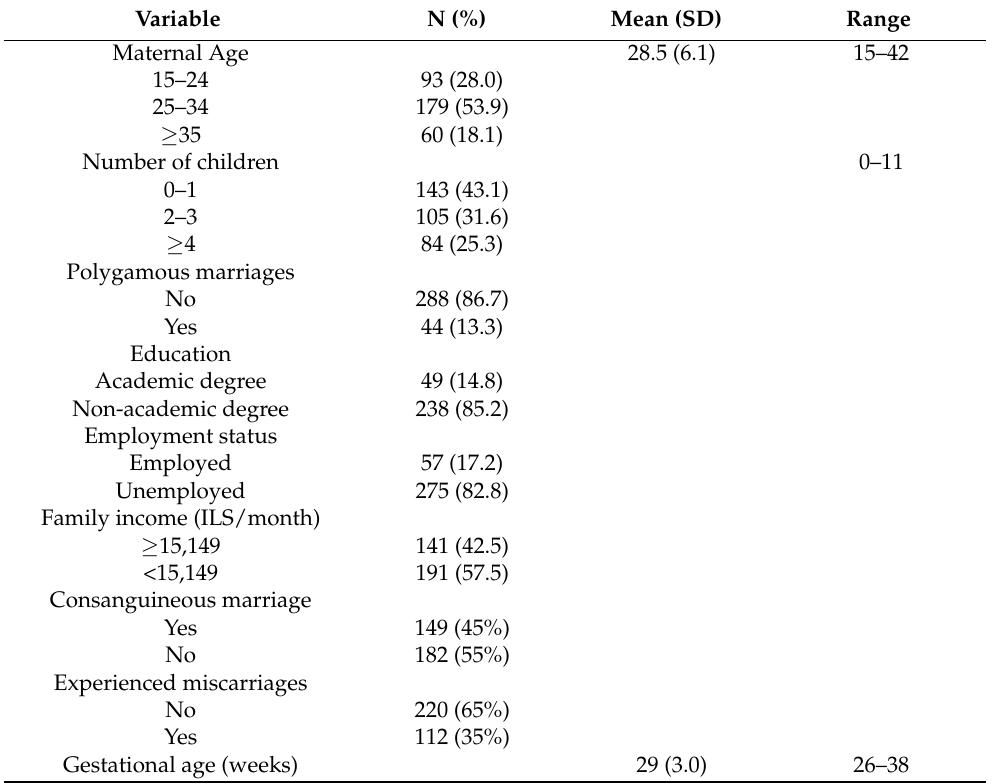
Table 1. Sociodemographic and clinical characteristics of participants (N = 332).